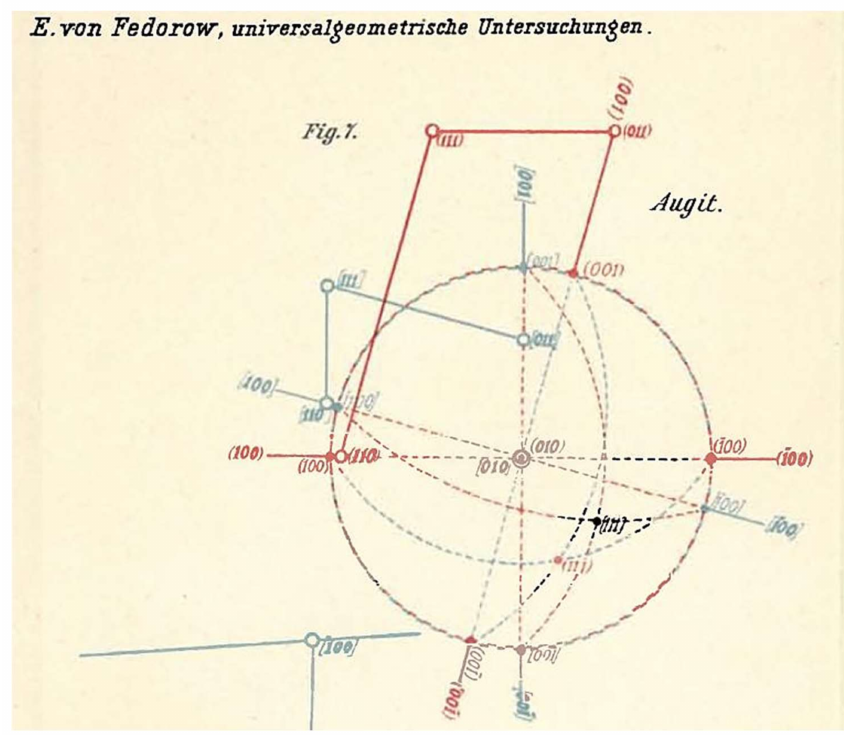
Figure 9. Universal geometrical studies. Combined stereographic and gnomonic projection of crystal forms and edges used by E. v. Fedorov. Faces appear in red color, zones in blue [32] (Table